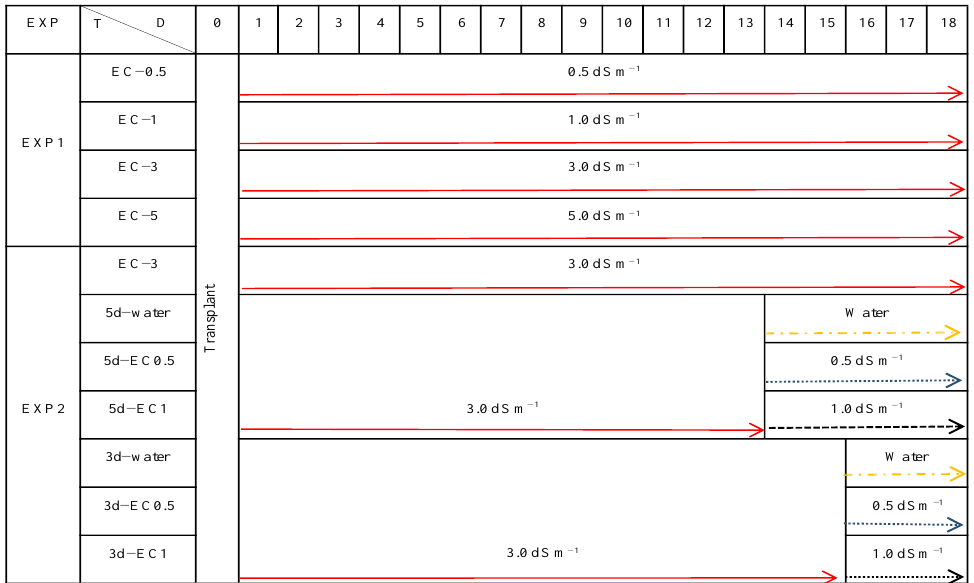
Figure 1. Schematic diagram of the treatments imposed on basil plants cultivated for 18 days in experiment 1 and experiment 2. Treatment code (T): EC − 0.5, EC − 1, EC − 3, and EC − 5 represent nutrient solution with electrical conductivities (ECs) of 0.5, 1.0, 3.0, and 5.0 dS m − 1 , respectively. 5d − water, 5d − EC0.5, and 5d − EC1 represent treatments with water, EC − 0.5, and EC − 1 imposed 5 days before harvest, respectively. 3d − water, 3d − EC0.5, and 3d − EC1 represent treatments with water, EC − 0.5, and EC − 1 imposed 3 days before harvest, respectively. D: days of cultivation. EXP: experiment. Table 1. Nutrient concentration of different EC treatments.